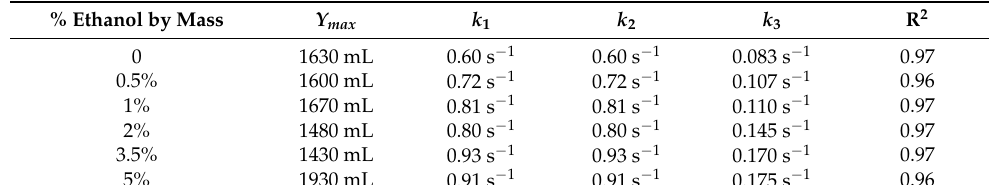
Table 1. Parameters used to fit kinetic foam data to Equation (8).